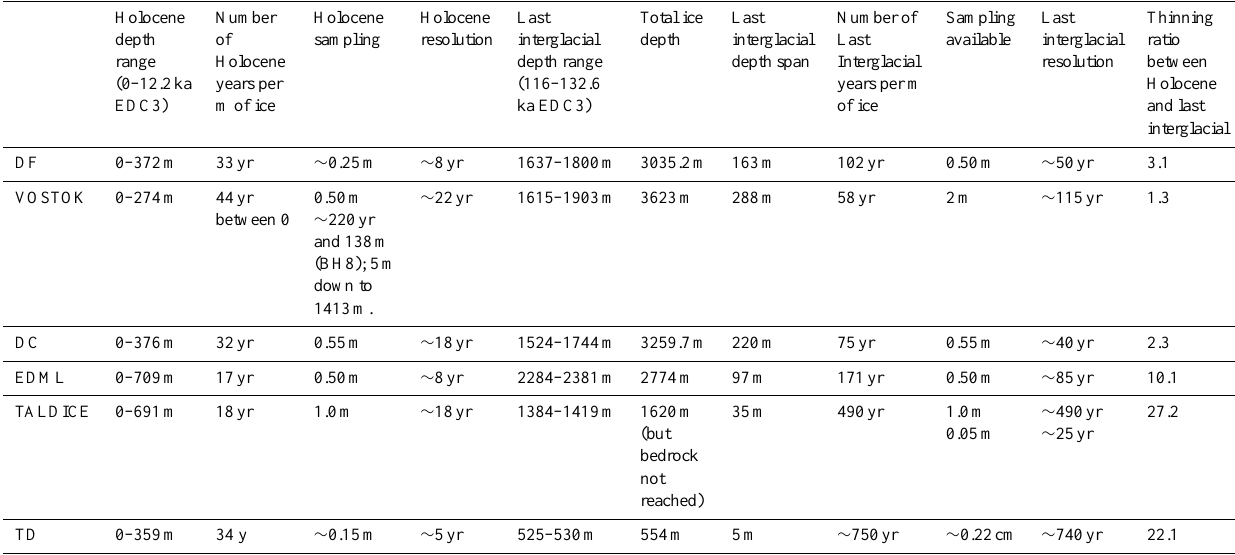
Table 2. Depth range where the present interglacial (in Antarctica, with EDC3 age scale, 0–12.1kyr) and last interglacial (with EDC3 age scale, 116–132.6kyr) ice is found in each deep ice core (in m), mean number of years per m of ice for each ice core and each time period, and thinning ratio between the two interglacial periods (estimated here as the ratio between the number of last interglacial years per m of ice to the number of Holocene years per m of ice). The beginning of last interglacial is found in the middle of the ice depth at DF (59%), Vostok (52%) and EDC (53%) but closer to bedrock at EDML (86%) and TALDICE (88%). Thinning is minimum at Vostok, due to the impact of subglacial Lake Vostok on ice flow, and is maximum for TALDICE and Taylor Dome above a dry